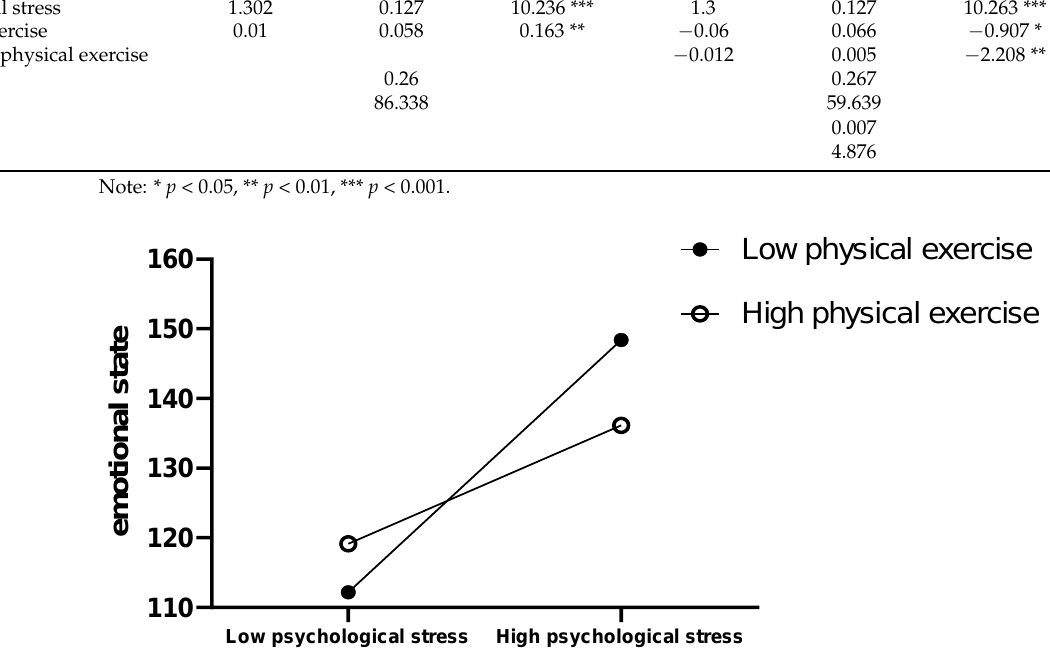
Figure 1. The regulating effect of physical exercise.